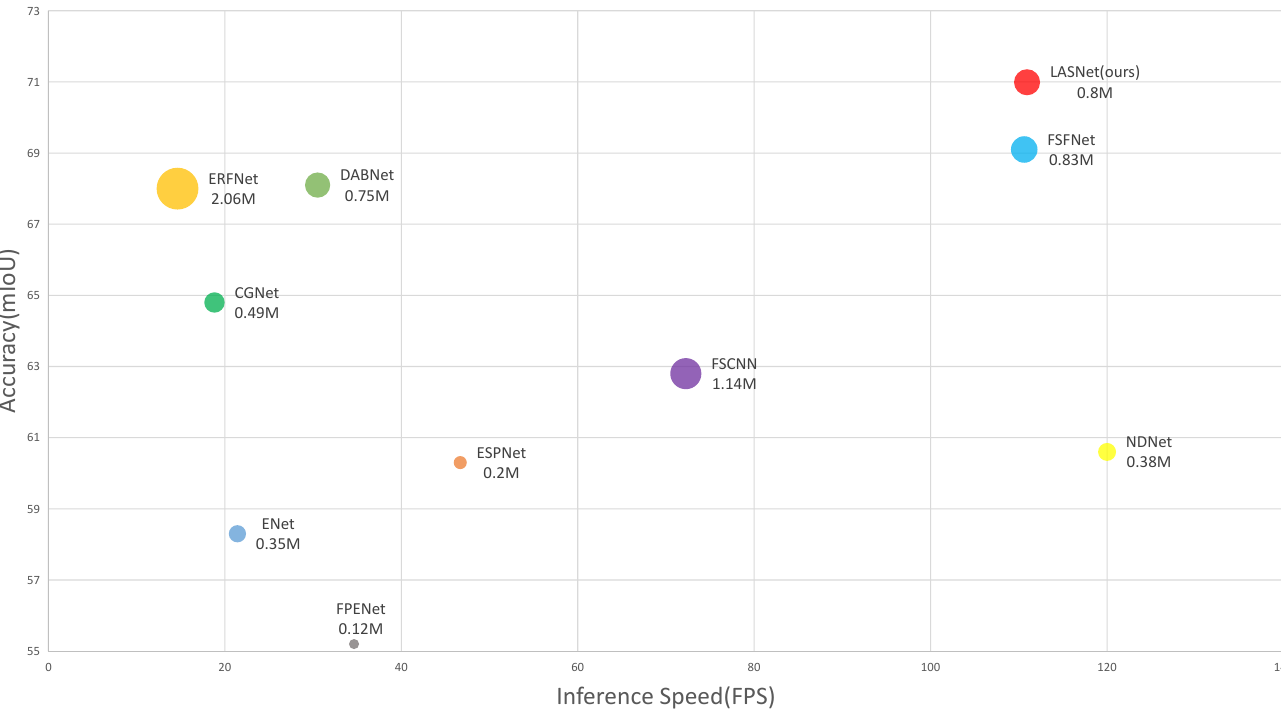
Figure 1. Compare with state-of-the-art network in terms of the available trade-off between accuracy and efficiency. (The circle size represents the